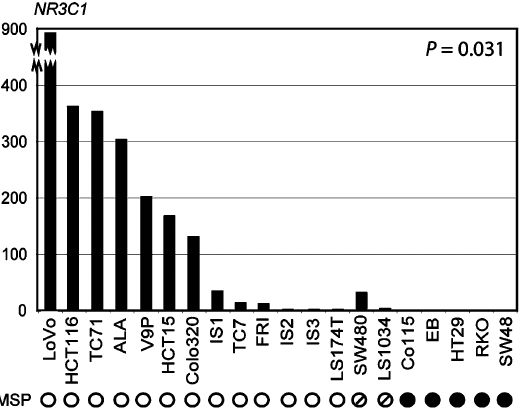
Fig. 3. Methylation status of individual CpG sites by bisulphite se- quencing in ADAMTS1 ( A ), CRABP1 ( B ), and NR3C1 ( C ). The up- per part of each panel is a schematic presentation of the CpG is- land in the area of transcription start amplified by the bisulphite se- quencing primers. The transcription start site is represented by + 1 and the vertical bars indicate the location of individual CpG sites. The two arrows indicate the location of the methylation-specific PCR primers. For the middle part of each panel, filled circles rep- resent methylated CpGs; open circles represent unmethylated CpGs; and open circles with a slash represent partially methylated sites (the presence of approximately 20–80% cytosine, in addition to thymine). The column of U, M and U/M at the right side of this middle part lists the methylation status of the cell line from MSP analyses of the respective genes. The lower part of each panel (high- lighted in grey) is a section of the bisulphite sequence electrophero- gram, where cytosines in CpG sites are underlined in black and cy- tosines that have been converted to thymines are underlined in red. The sequencing electropherograms illustrated here, are from SW48, Co115, and Co115, respectively. Abbreviations: MSP, methylation- specific PCR; s, sense; as, antisense; U, unmethylated; M, methy- lated; U/M, presence of both unmethylated and methylated band.